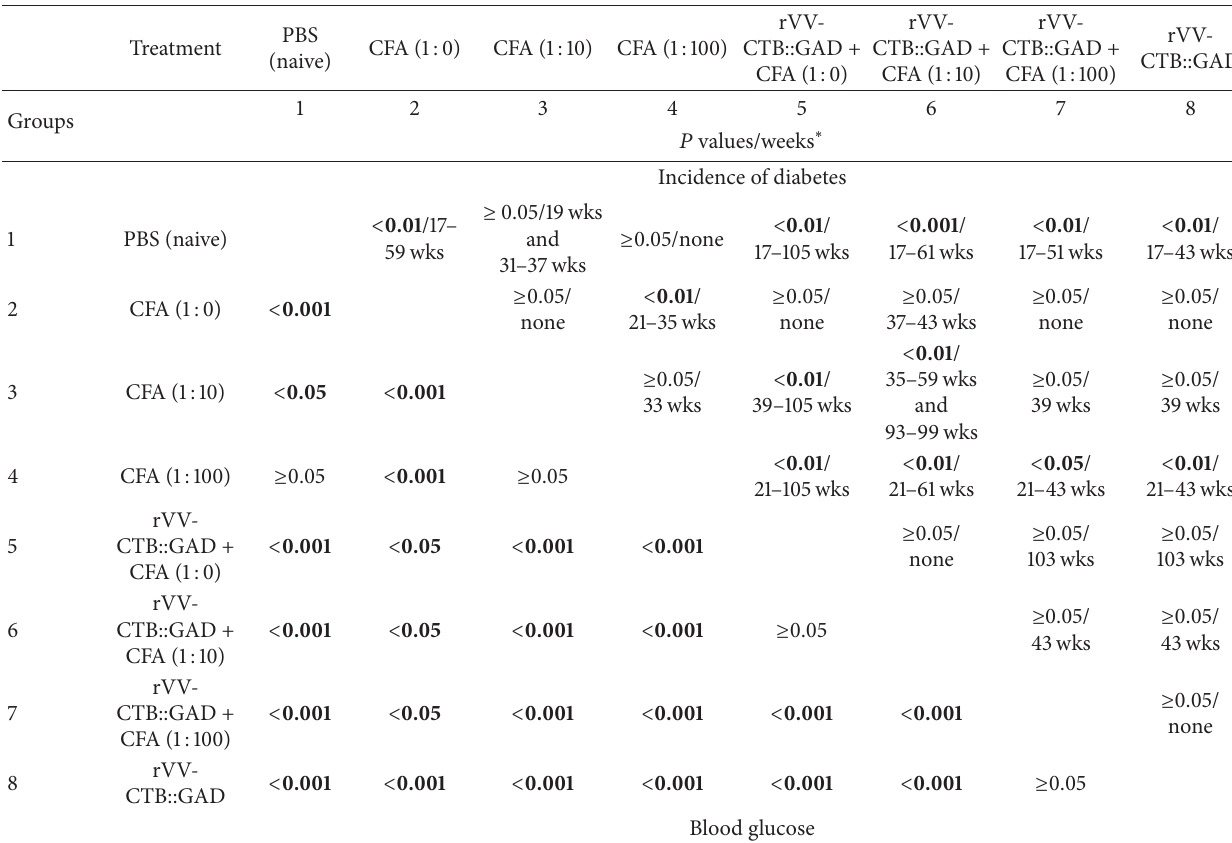
Table 2: Analysis of hyperglycemia